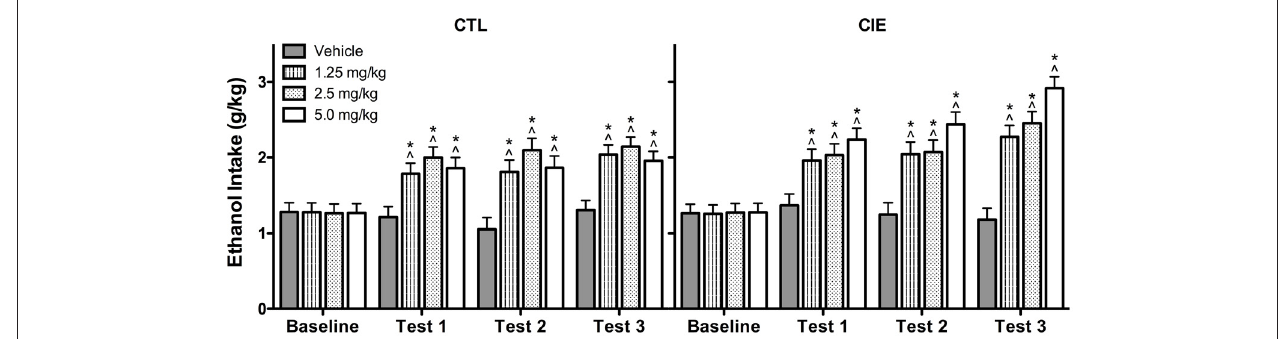
FIGURE 5 | Average weekly ethanol consumption (g/kg). All doses of the KOR agonist U50,488 resulted in elevated ethanol consumption relative to baseline drinking (indicated by ∧ ) and vehicle-injected controls (indicated by ∗ ) during Tests 1–3 for both CIE and CTL mice.